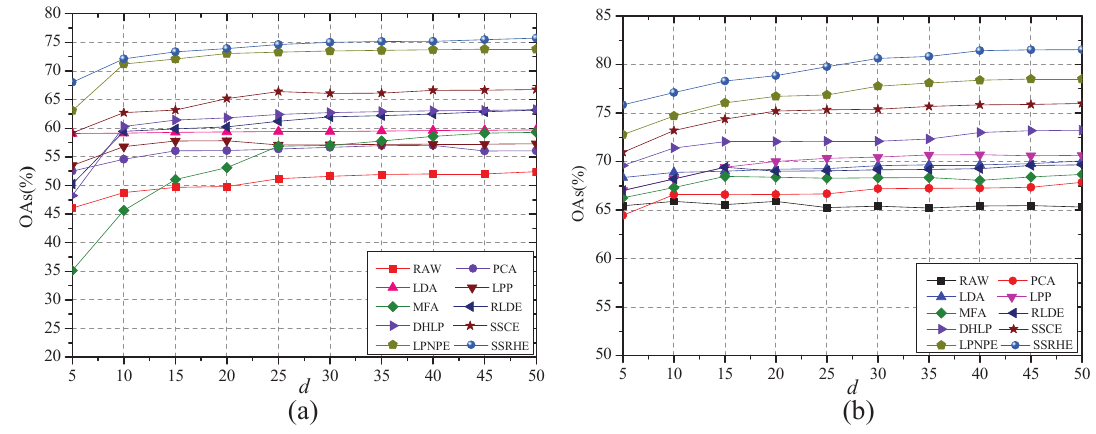
Figure 9. OAs with different embedding d : ( a ) Indian Pines dataset; anf ( b ) Pavia U dataset.